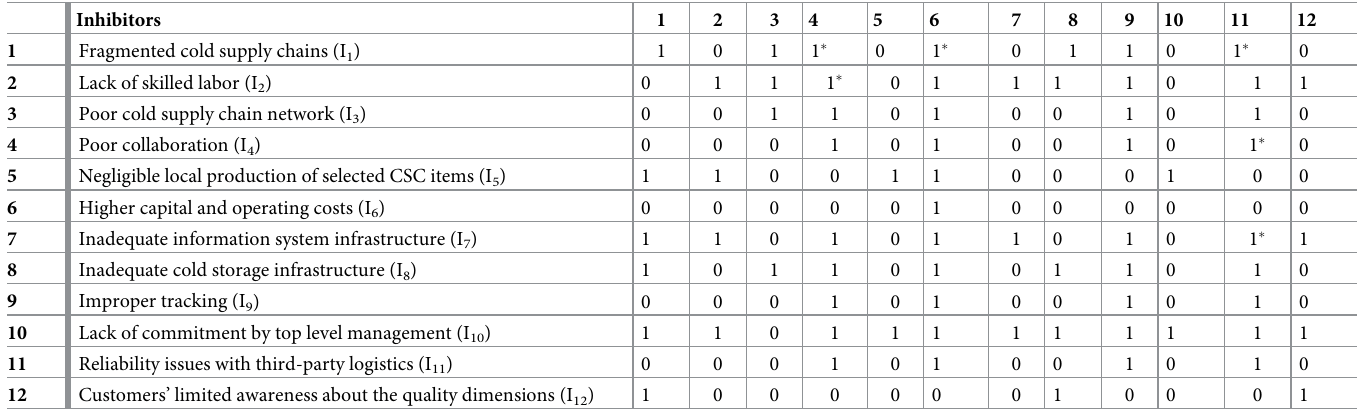
Table 4. Final reachability